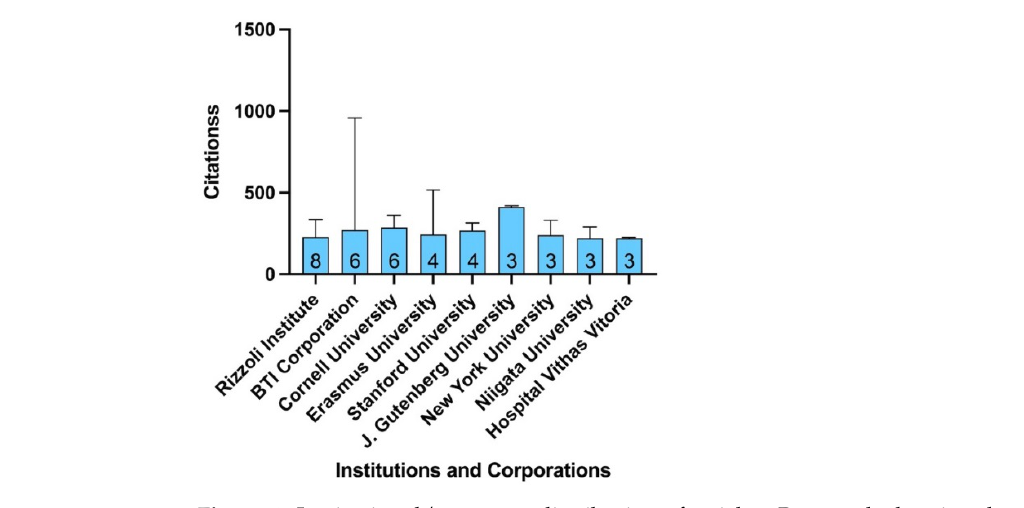
Figure 4. Institutional/corporate distribution of articles. Bar graph showing the median number of citations (and maximum) for the most-cited articles according to the institutional/corporate distribution of articles (number of articles at the bottom of the bar). BTI, Biotechnology Institute; J, Johannes; LA, Los Angeles. Table 2. Authors with two or more top-cited